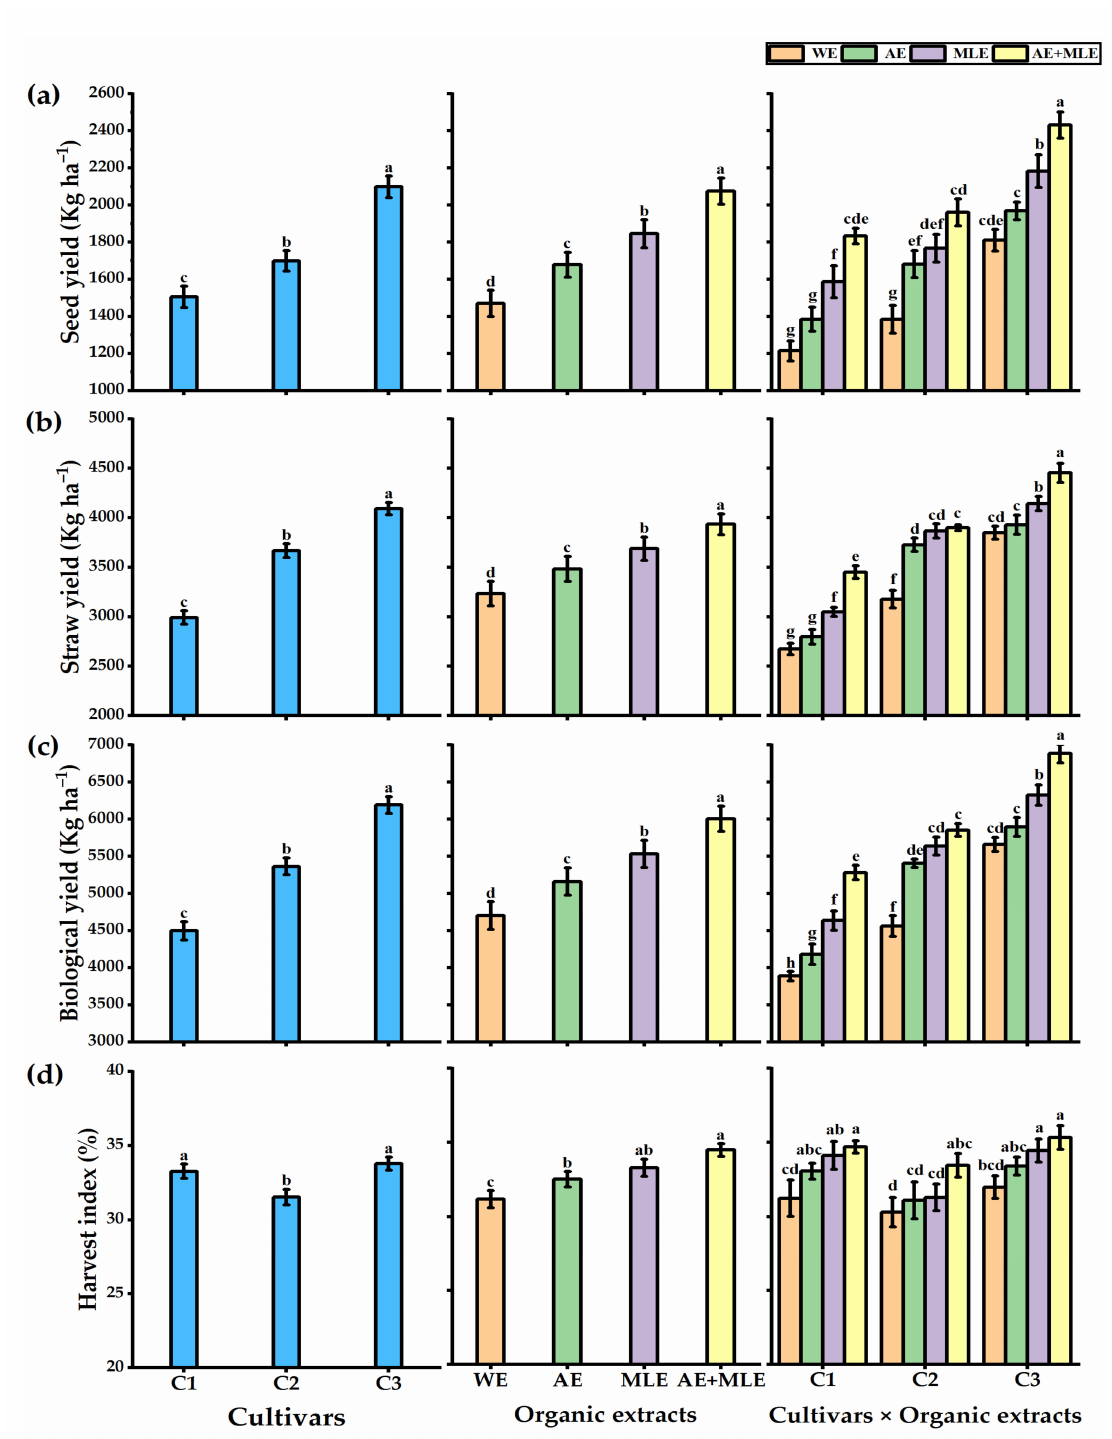
Figure 2. Effect of Azolla extract, moringa leaf extract, and their combination on ( a ) seed yield (kg ha − 1 ), ( b ) straw yield (kg ha − 1 ), ( c ) biological yield (kg ha − 1 ), and ( d ) harvest index (%) of three quinoa cultivars. C1 = KVL − SRAZ, C2 = Chipaya, C3 = Q-37, WE = without extract, AE = Azolla extract, MLE = moringa leaf extract. Data are mean value ± SE, n = 3. Different letters denote significant differences at p ≤ 0.05